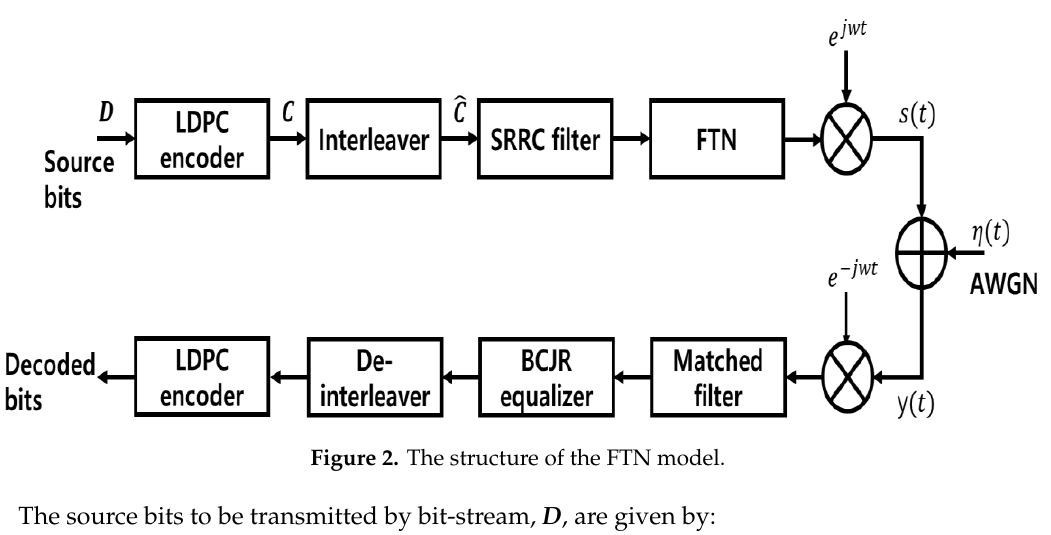
Figure 2. The structure of the FTN model.